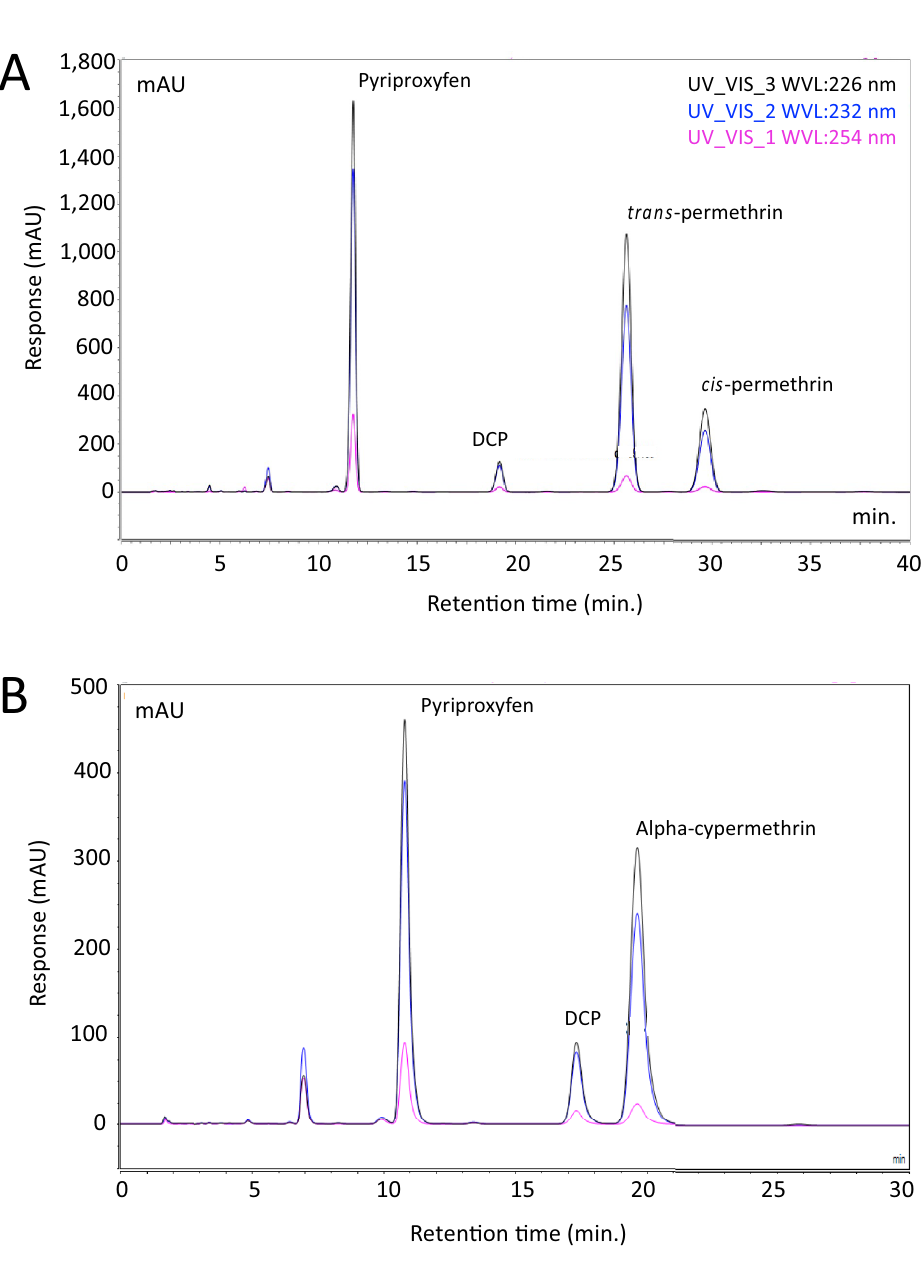
Figure 3. HPLC chromatogram for pyriproxyfen and pyrethroids extracted from Olyset® Duo and Royal Guard® LLINs with reference to internal standard ‘dicyclohexyl phthalate (DCP). ( A ) Olyset® Duo active ingredients, pyriproxyfen and trans -permethrin and cis permethrin, measured by HPLC-diode array detector (DAD) at three-wavelength 226 (black), 232 (blue) and 254 (purple) nm in LLIN extraction solution. ( B ) Royal Guard® active ingredients; pyriproxyfen, and alpha - cypermethrin, were detected at the same three-wavelength in the sample solution following LLIN